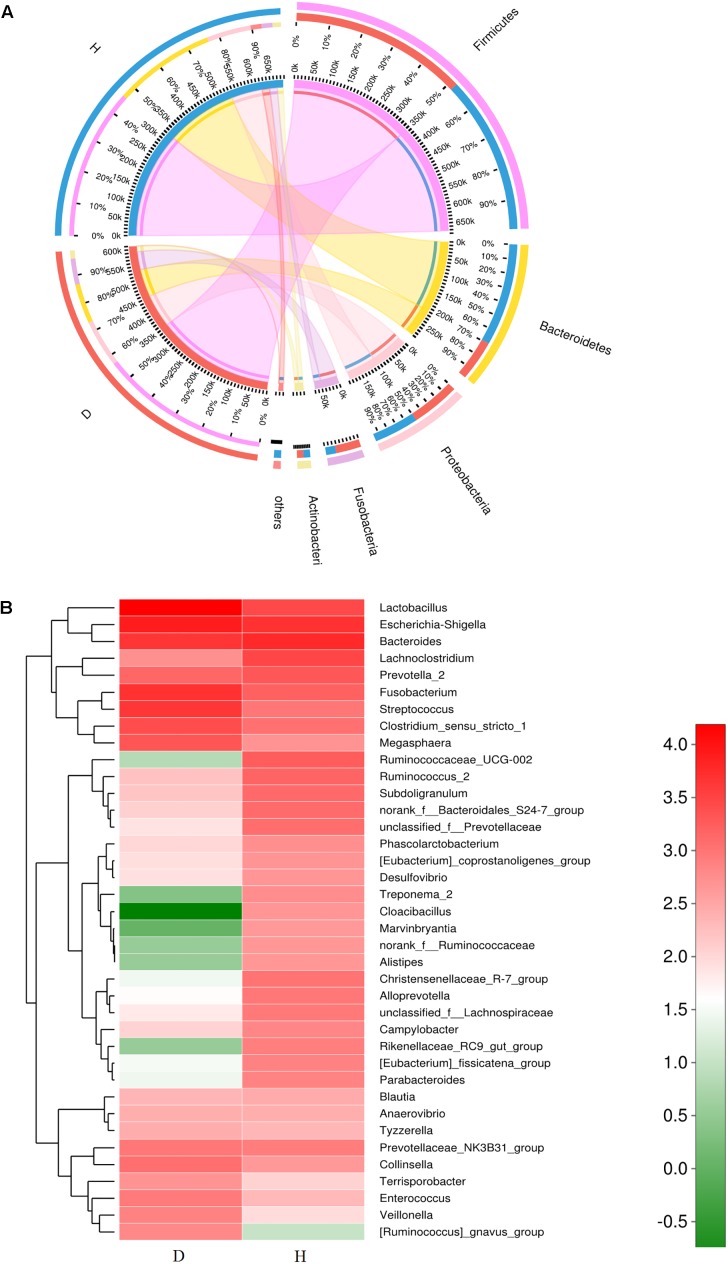
Relative abundance of sequences at the phylum and genus levels in diarrheal (D) and healthy (H) groups. (A) Collinear relation diagram between samples and bacterial phylum. (B) Heatmap analyses of abundant genera in each group. The heatmap plot depicts the relative percentage of each bacterial genus (variables clustering on the vertical-axis) within each group (horizon-axis clustering). The color of the spots in the right panel represents the relative values (lg) of the genera in each group.